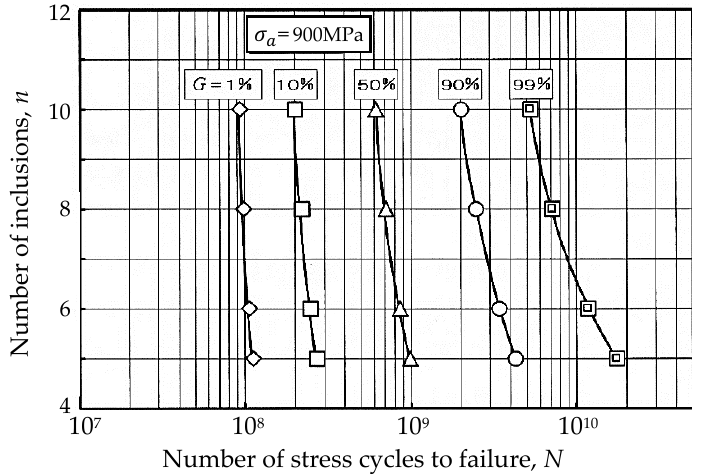
Figure 13. Number of inclusions versus number of stress cycles to failure.